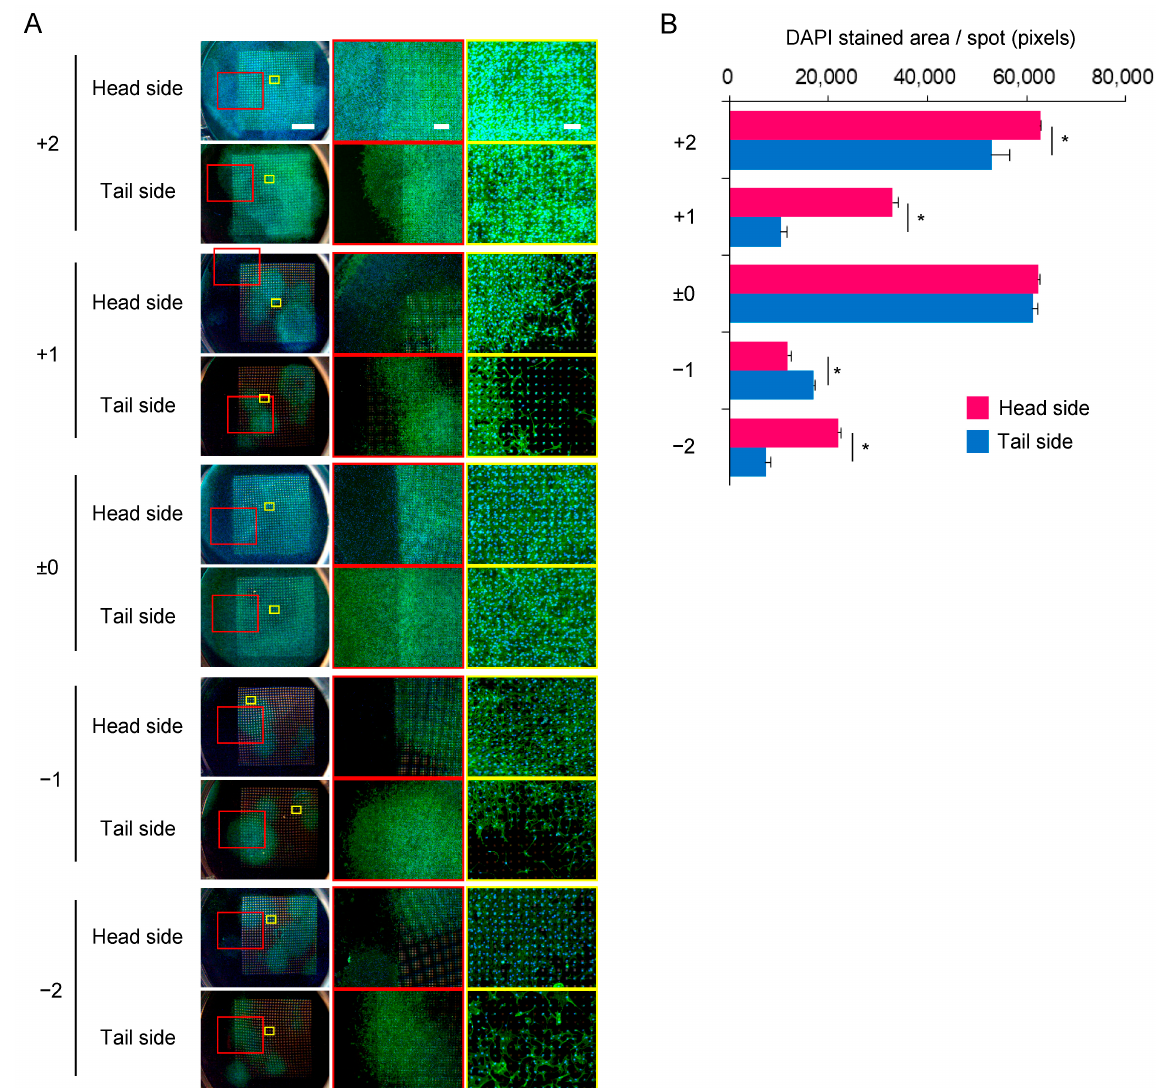
Figure 6. The migration of C3H10T1/2 cells to neighboring Ti membranes. The substrate on which the cells were incubated for 24 h was placed between four new membranes and cultured for 10 days (first multi ‐ layered culture). The membrane with seeded cells was defined as “±0.” The upper layers were assigned positive numbers, whereas the lower layers were assigned negative numbers. ( A ) The cells were stained for F ‐ actin (green) and nuclei (blue). The images are shown at three magnifications (the scale bars represent 150, 750, or 3000 μ m). ( B ) The stained areas of nuclei in panel A were quantified. The significance is represented as * p < 0.05.